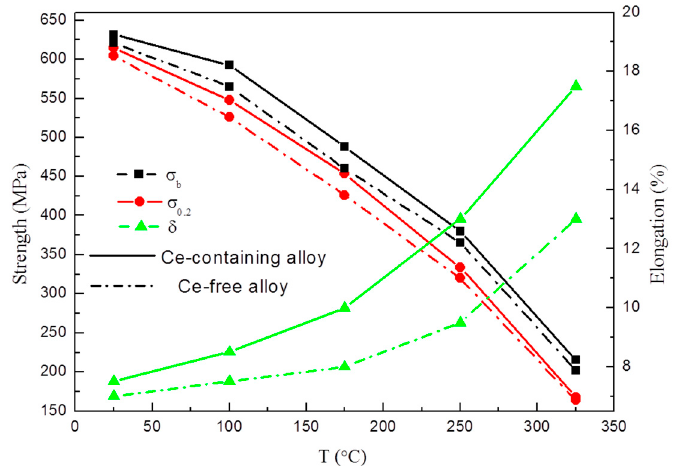
Figure 9. High-temperature tensile curves of Ce-containing and Ce-free alloys at T8 temper.